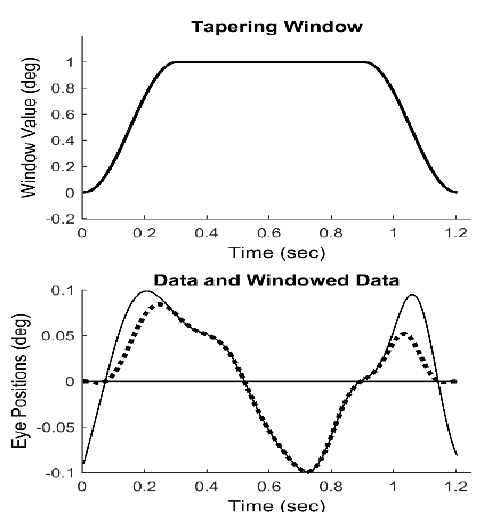
Figure 4: Upper Plot: The Tukey tapering window. Lower Plot: The nonzero end-points seen in the original isolated data (solid line) are reduced to zero (dotted line) after multiplication with the Tukey window.